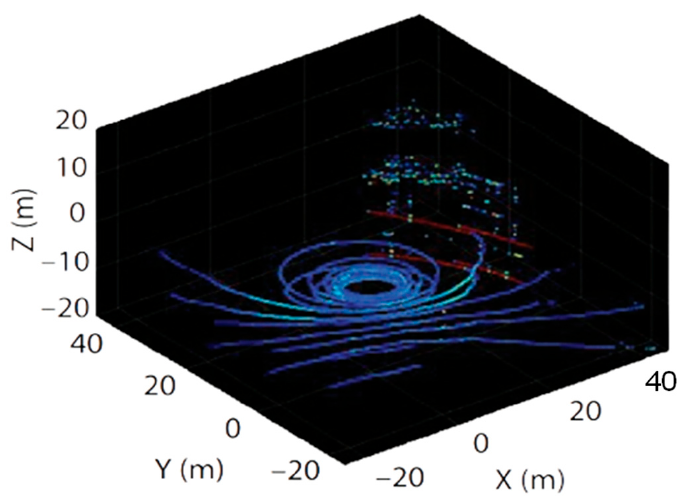
Figure 2. LiDAR PC data from PCAP file.